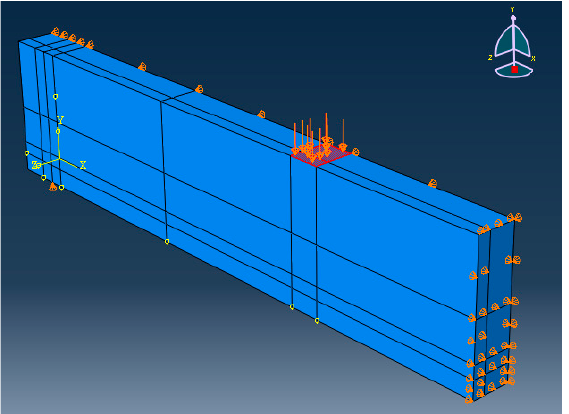
Figure 3. Structural boundary